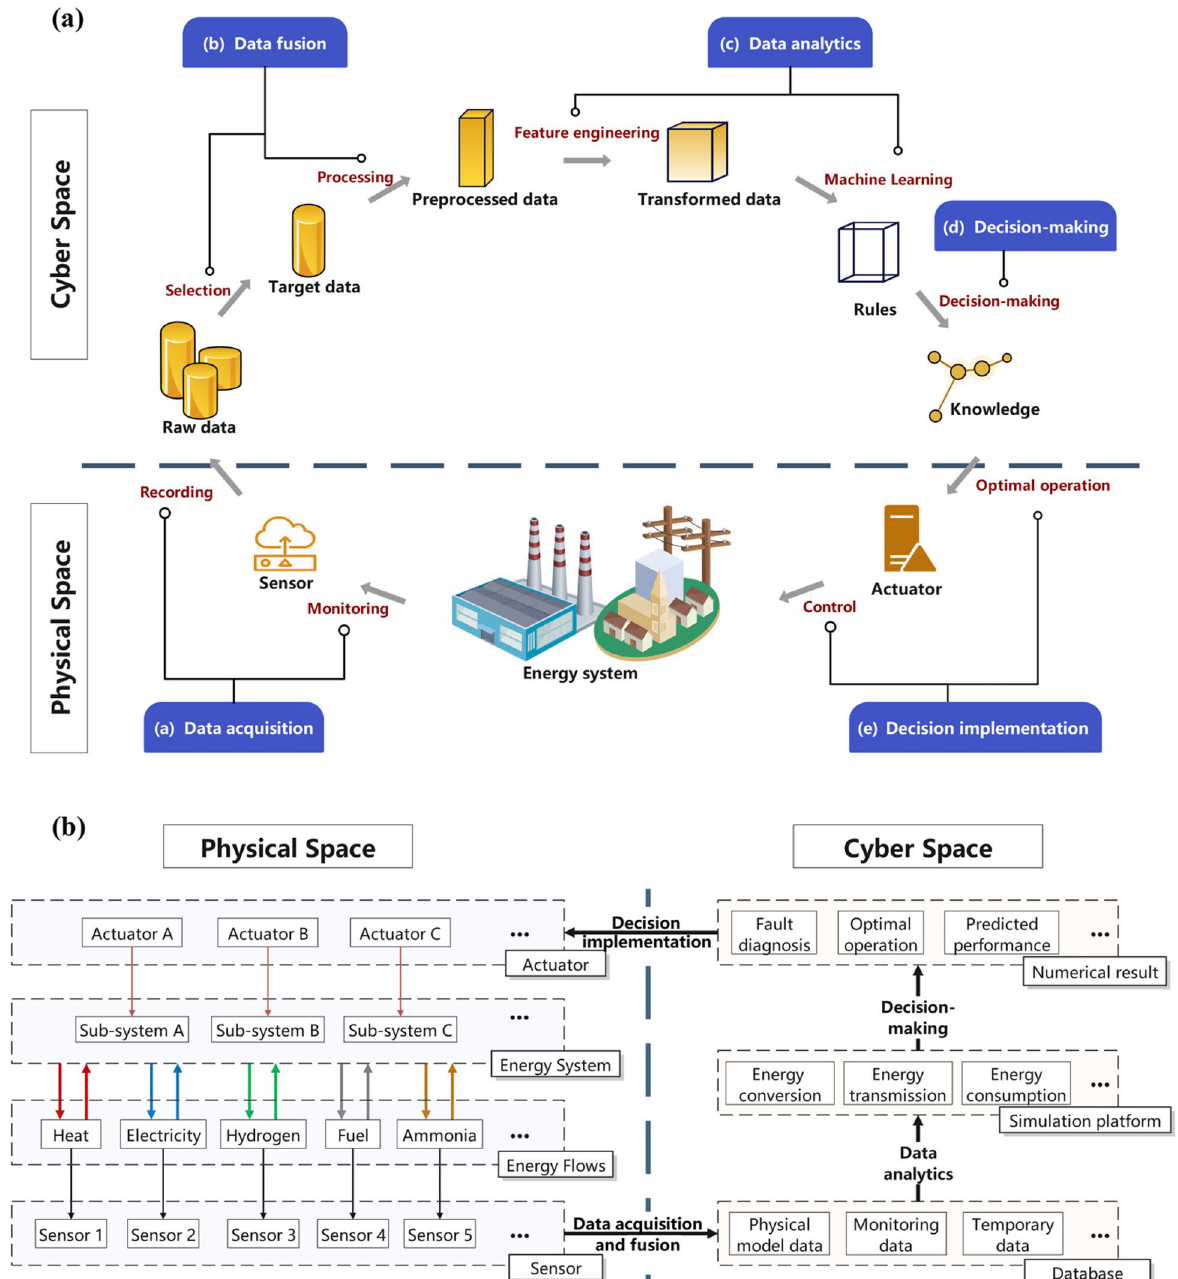
Fig. 2 Schematic of energy system digitization: a a holistic working flow; b links between physical and cyber